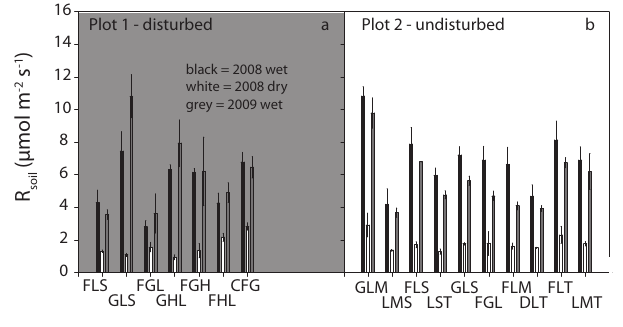
Fig. 4. Differences in averaged soil respiration are shown for sub- plots for the different years and seasons. Data for only 2 of the in- ventory plots are given, where (a) (grey highlighted) represents the disturbed area showing higher values of R soil in 2009 (grey bars) compared to 2008 (black bars) and (b) represents the undisturbed area showing the exactly opposite result. Smallest efflux rates were always observed during the dry season (white bars). Categories are given according to Tables 1 and